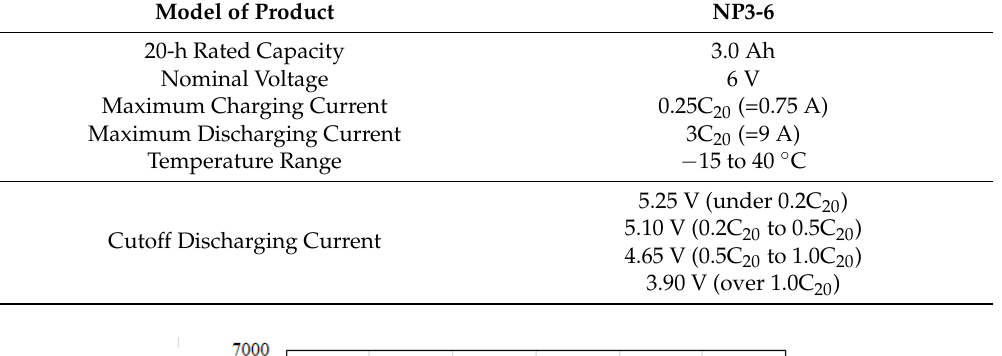
Figure 9. Discharging characteristic of Ni-MH 2 cell in series during CCCV mode.